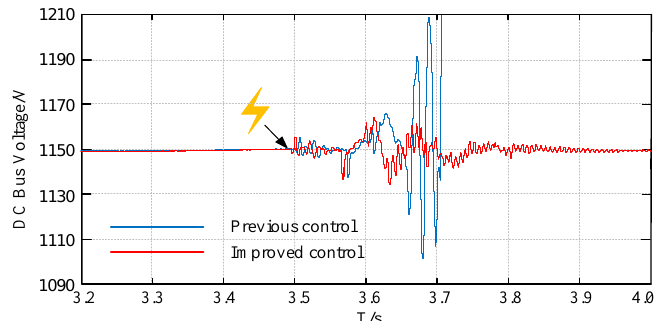
Figure 14. The DC bus voltage of the Hornsea 1B.